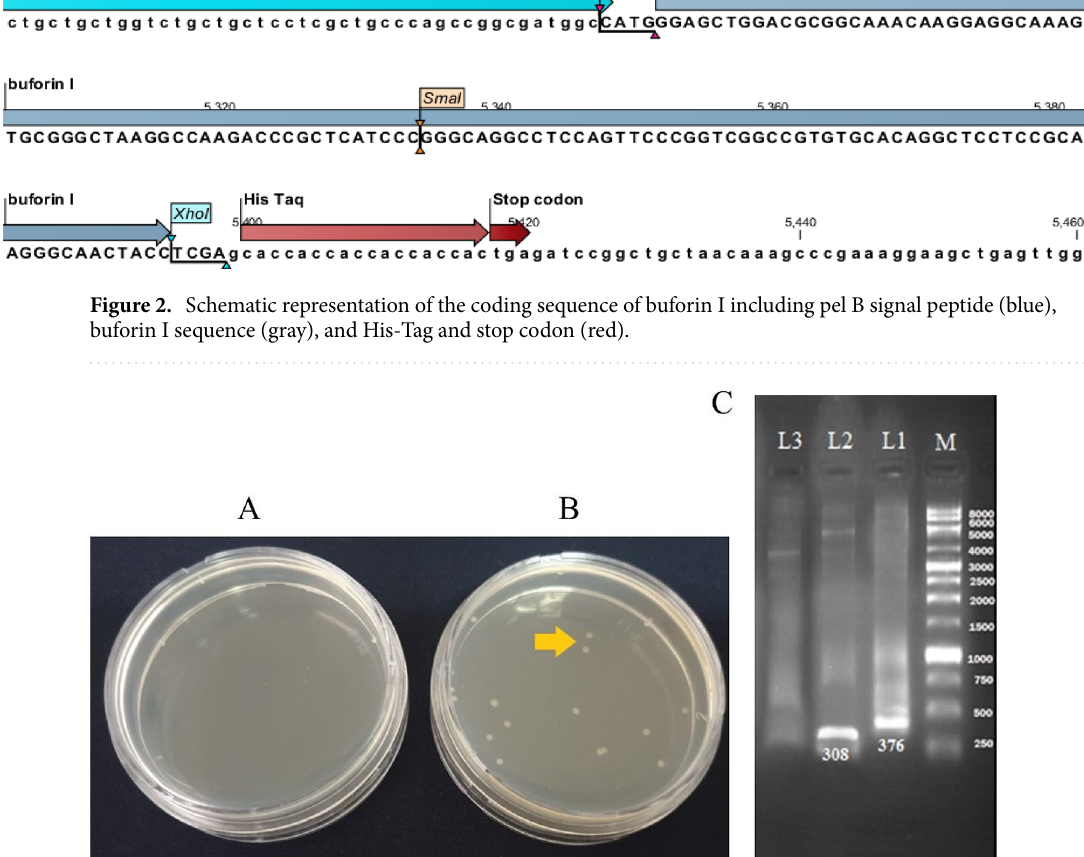
Figure 3. ( A ) No colony formation by bacteria without recombinant plasmid on the medium containing ampicillin, and ( B ) Colony formation (yellow arrow) by bacteria with recombinant plasmid; ( C ) Colony PCR analysis of the recombinant plasmid from E. coli DH5 α: M: 1 kbp DNA Ladder, L1: PCR product of E. coli DH5α harboring recombinant plasmid pET22 b (+)-BUF, L2: PCR product of E. coli DH5α harboring an intact plasmid pET22 b (+) (positive control), L3: PCR product of Plasmid-free E. coli DH5α (negative